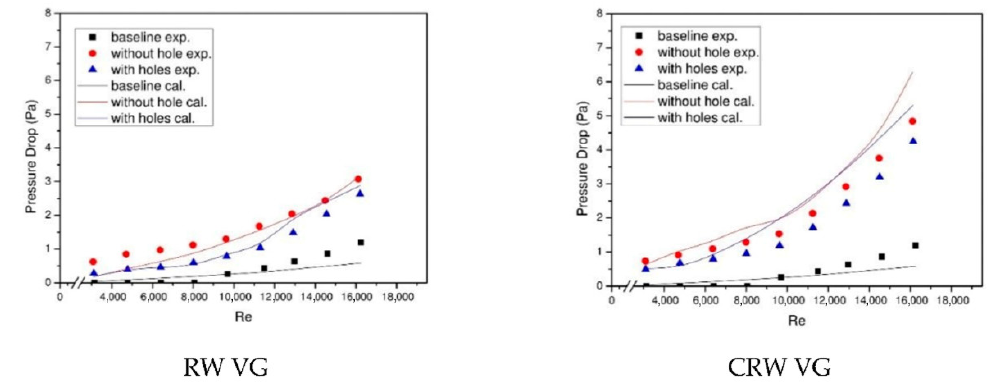
Figure 13. Comparison of flow pressure drop between RW and CRW VGs use with/without holes as well as baseline.